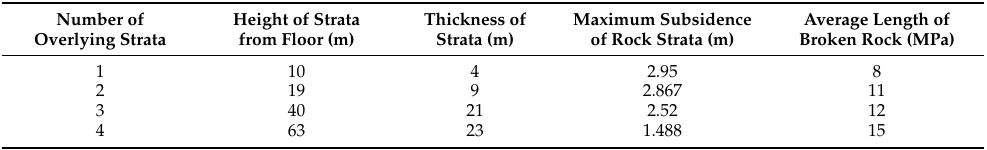
Table 1. Characteristic parameters of overlying